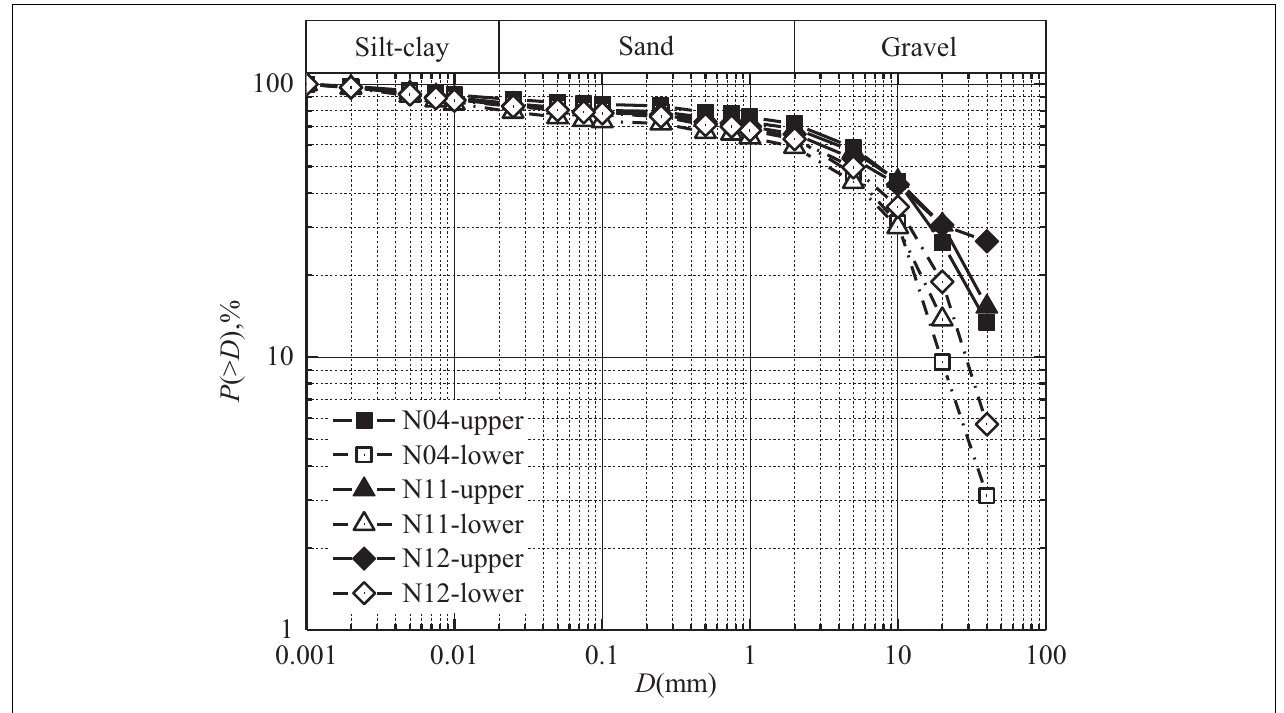
FIGURE 3 | GSD of overlying coarse and underlying layers of surges N04, N11, and N12.